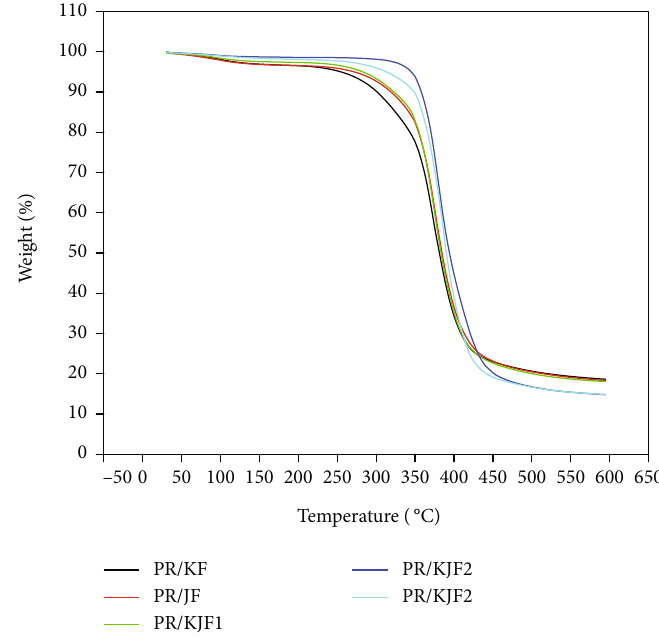
Figure 5: TGA curves for KF and JF